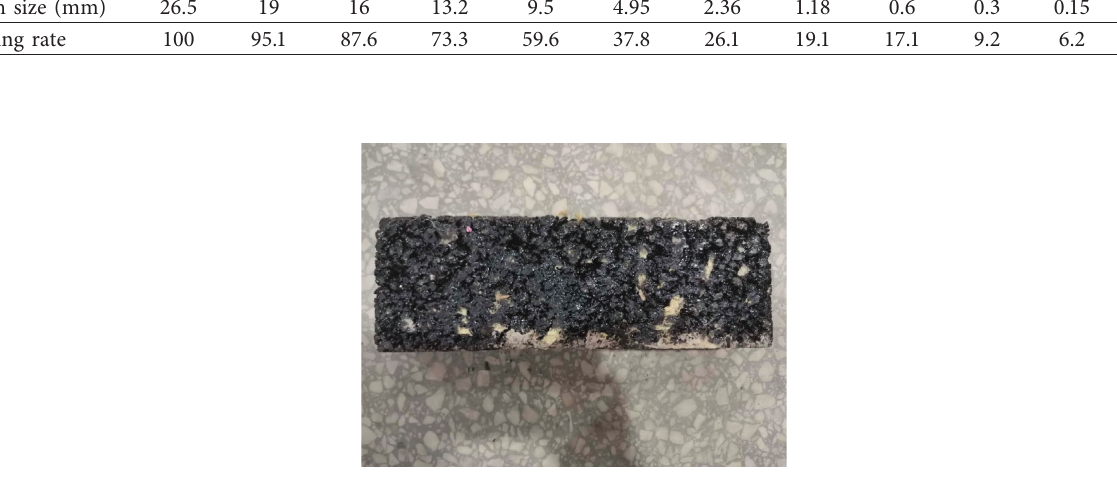
Figure 8: Specimen after cutting rut plate.